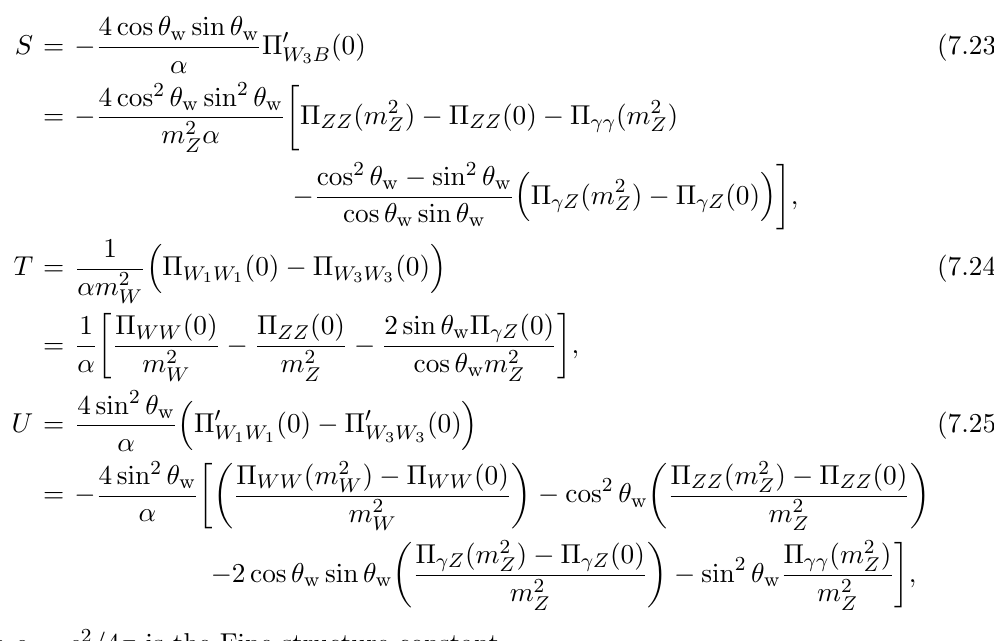
] represents the (cid:15)